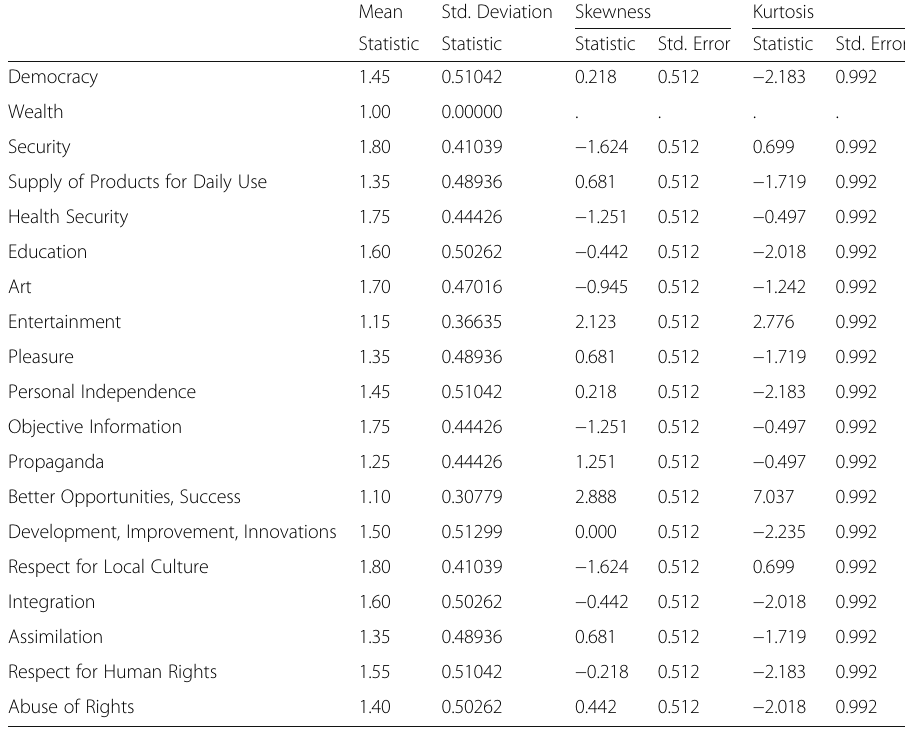
Table 6 Associations: the U.S. vs EU Mean Std. Deviation Skewness Kurtosis Statistic Statistic Statistic Std. Error Statistic Std.